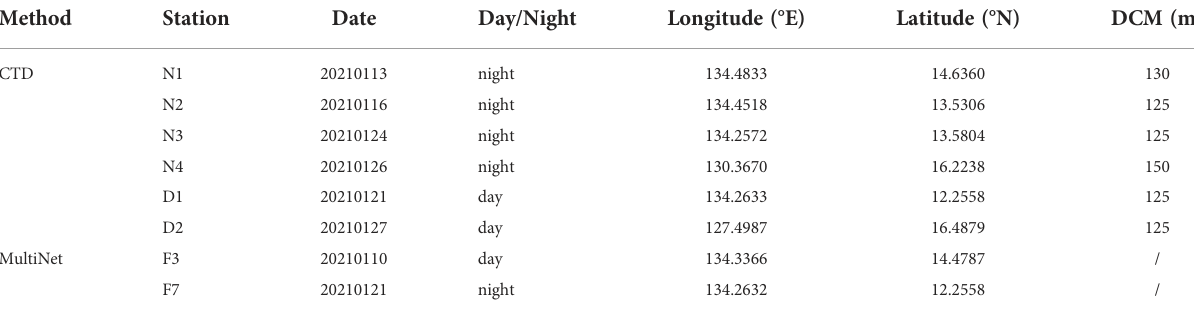
TABLE 1 Summary of environmental DNA and MultiNet